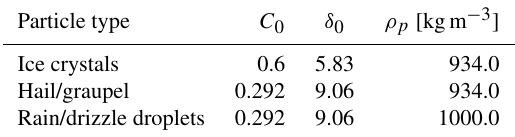
Table B1. Parameters for velocity calculations (Böhm, 1989,